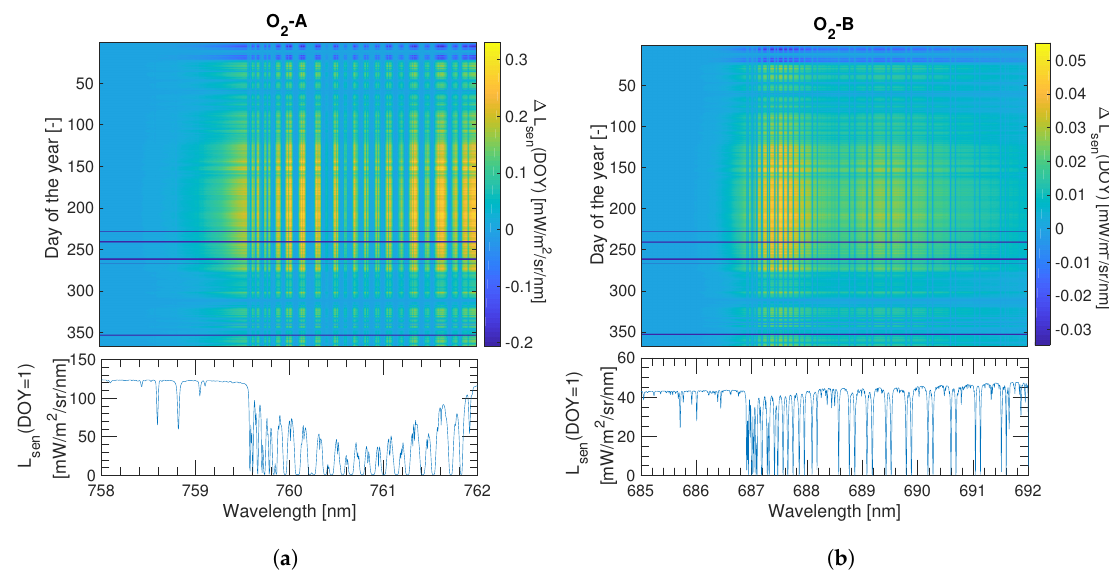
Figure 15. Variation in radiance units computed as L sen (DOY)- L sen (DOY=1) for the O 2 –A ( a ) and the O 2 –B ( b ) absorption regions. The acronym DOY refers to the Day Of Year from